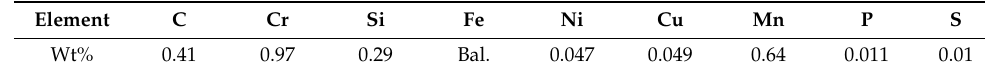
Figure 1. The piston rod. Table 1. Chemical composition of 40 Cr (wt%).